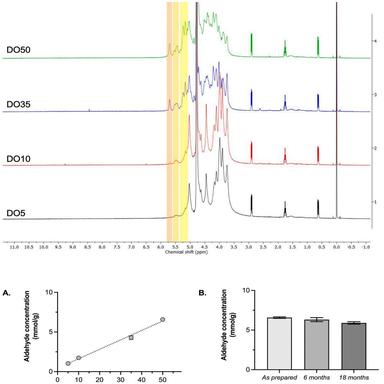
1 H NMR spectra for OAs in from − 1.0 ppm to 12.0 ppm. All spectra are calibrated based on DSS signal at δ = 0.00 ppm and represented as DO5 (black line), DO10 (red line), DO35 (blue line) and DO50 (green line). In all OAs, new peaks in the range between 5.1 ppm and 5.7 ppm were detected; with intensity proportional to the DO. Characteristic bands were identified and colour-coded for the regions in the range of: 5.77–5.63 ppm (orange region) with peak at 5.71 ppm, 5.62–5.39 ppm (gold region) with peak at 5.